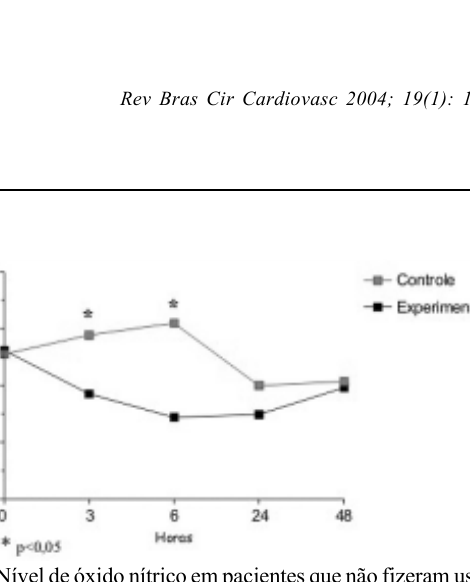
Fig. 7 - Nível de óxido nítrico em pacientes que não fizeram uso de vasodilatadores no O TNF α mostrou diferença significativa na 3ª e 48ª hora pós-CEC, sendo maior no grupo controle (Figura 5 e Tabela 1). O óxido nítrico mostrou diferença significativa na 6ª hora após o término de CEC, sendo maior no grupo controle.